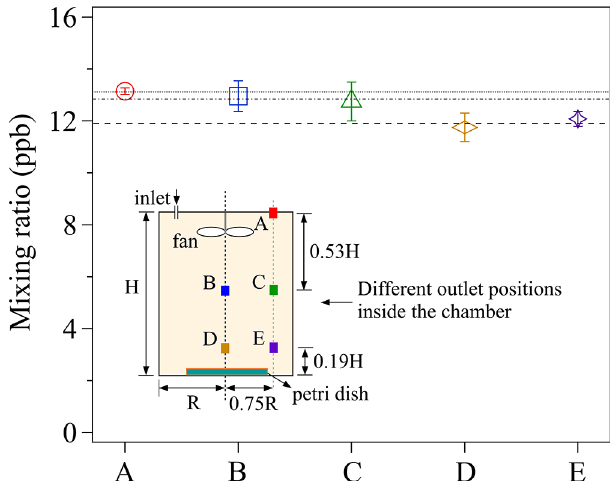
Figure 4. The effects of different chamber outlet positions on ob- served C out . The labels (A–E) of the x axis represent the different outlet positions shown in the chamber sketch, and the lines are the averaged mixing ratios at the three different vertical outlet heights (A; B/C; D/E). The error bars represent the standard deviation of three replicate experiments. For details, see the